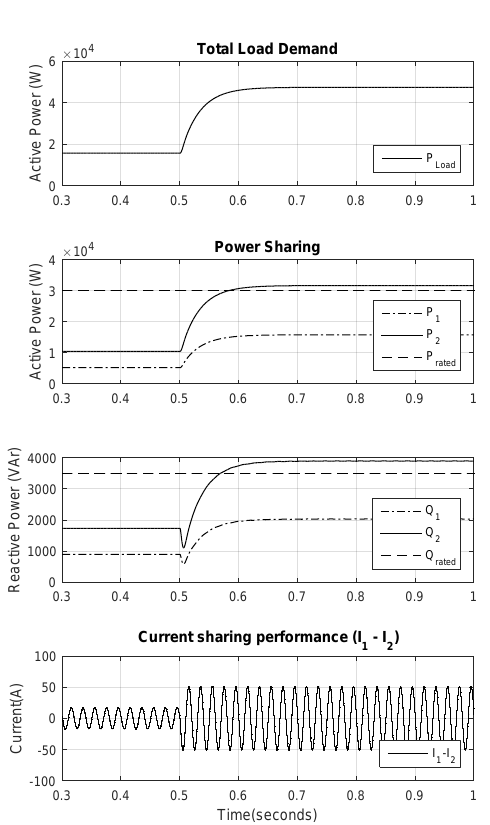
Figure 2. Transient response to a load change in an MG without power sharing